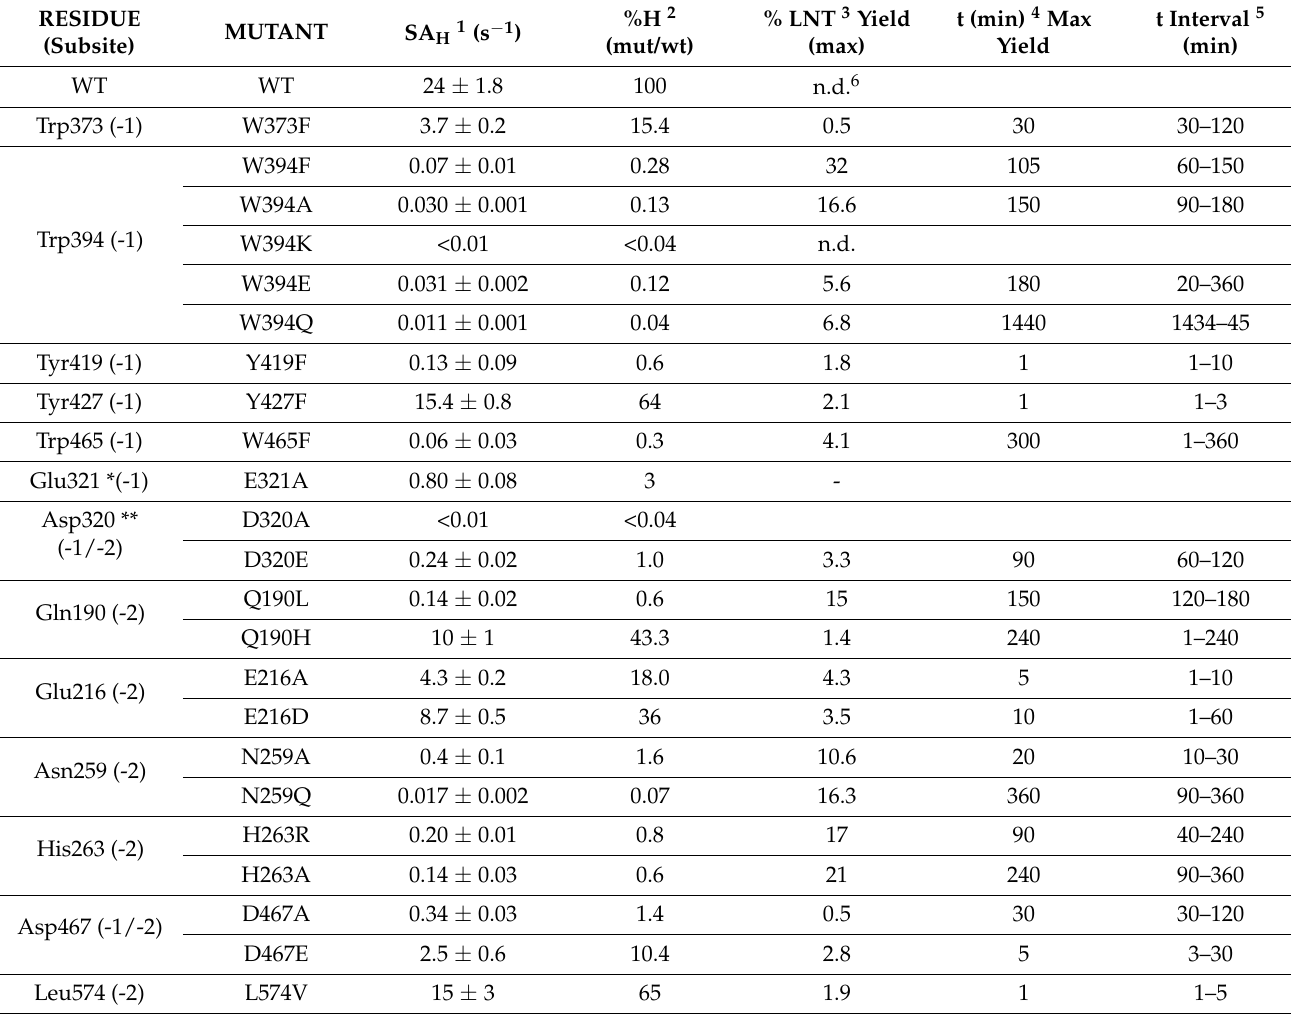
Table 1. Hydrolase activity on LNB- p NP and transglycosylation yields for LNT by LnbB